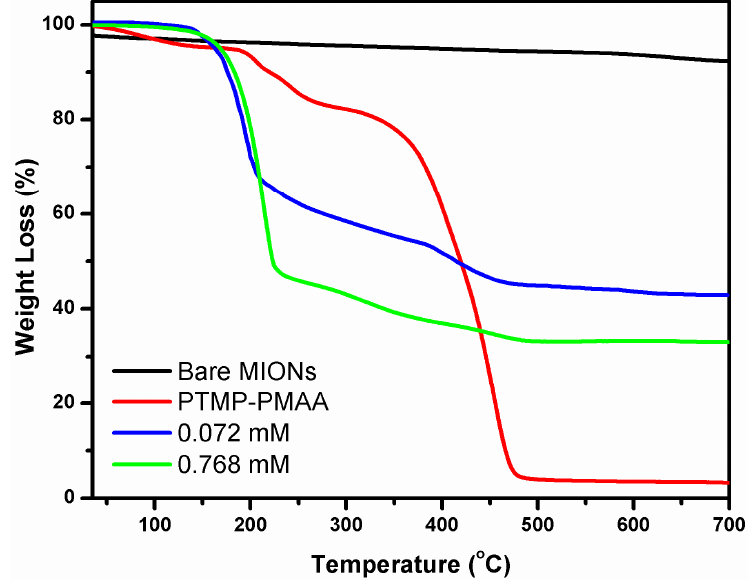
Figure 7. Thermogravimetric analysis (TGA) curves of PTMP-PMAA, MIONs with PTMP-PMAA (0.072 mM and 0.768 mM) and bare MIONs.